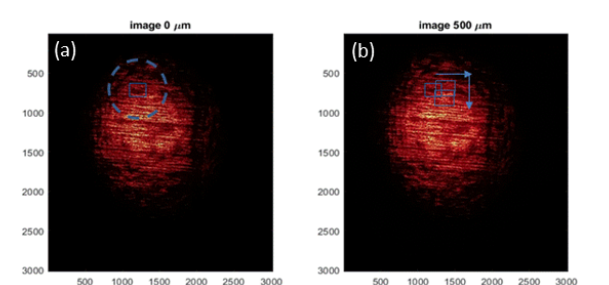
Figure 5. A windowed pattern chosen as the kernel to compute the correlation between the two